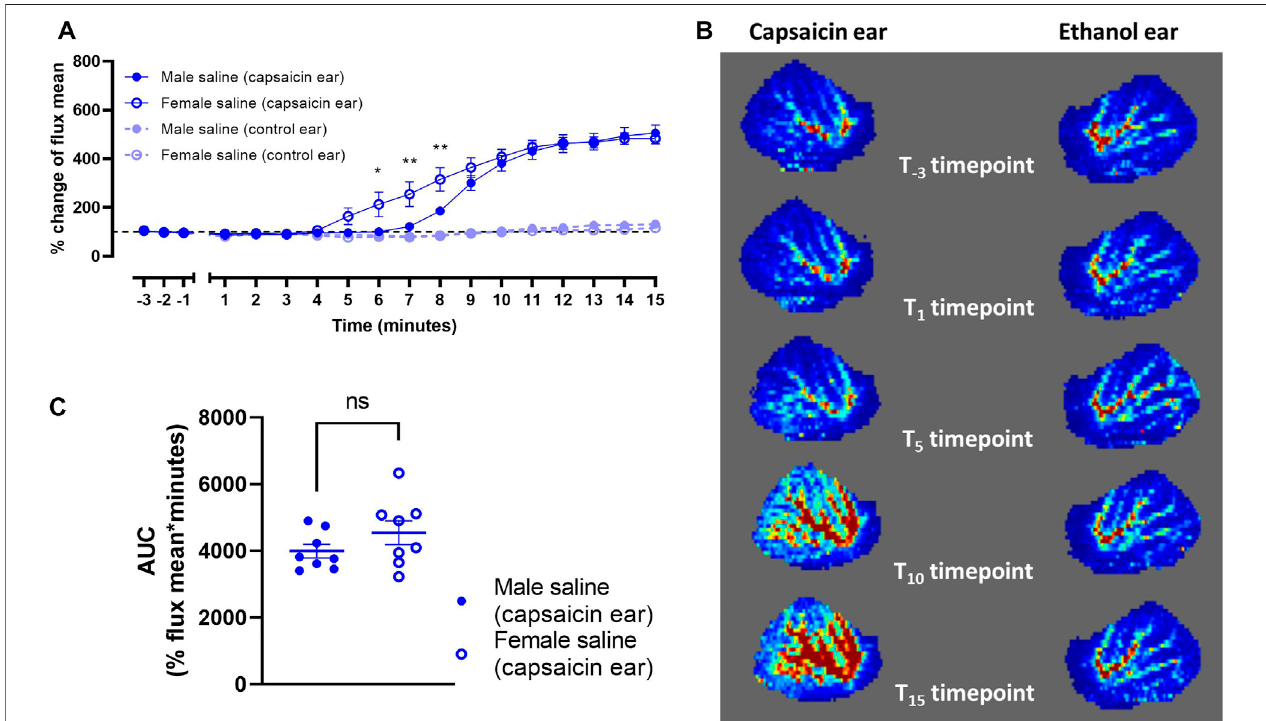
FIGURE6| Capsaicin-induceddermalvasodilationinmouseearsofsaline-treatedmale( n =8)andfemalemice( n =8). (A) Vasodilatoryresponsesofearsfollowing application of either capsaicin or ethanol (control). (B) Representative laser doppler fl ux images captured over the 15 min time course. (C) Corresponding area-under- curve (AUC) mean values over the 15 min time course for capsaicin-applied ears of male and female mice. Time points are marked where data points differ signi fi cantly between sex. ns p > 0.05, * p < 0.05, ** p <